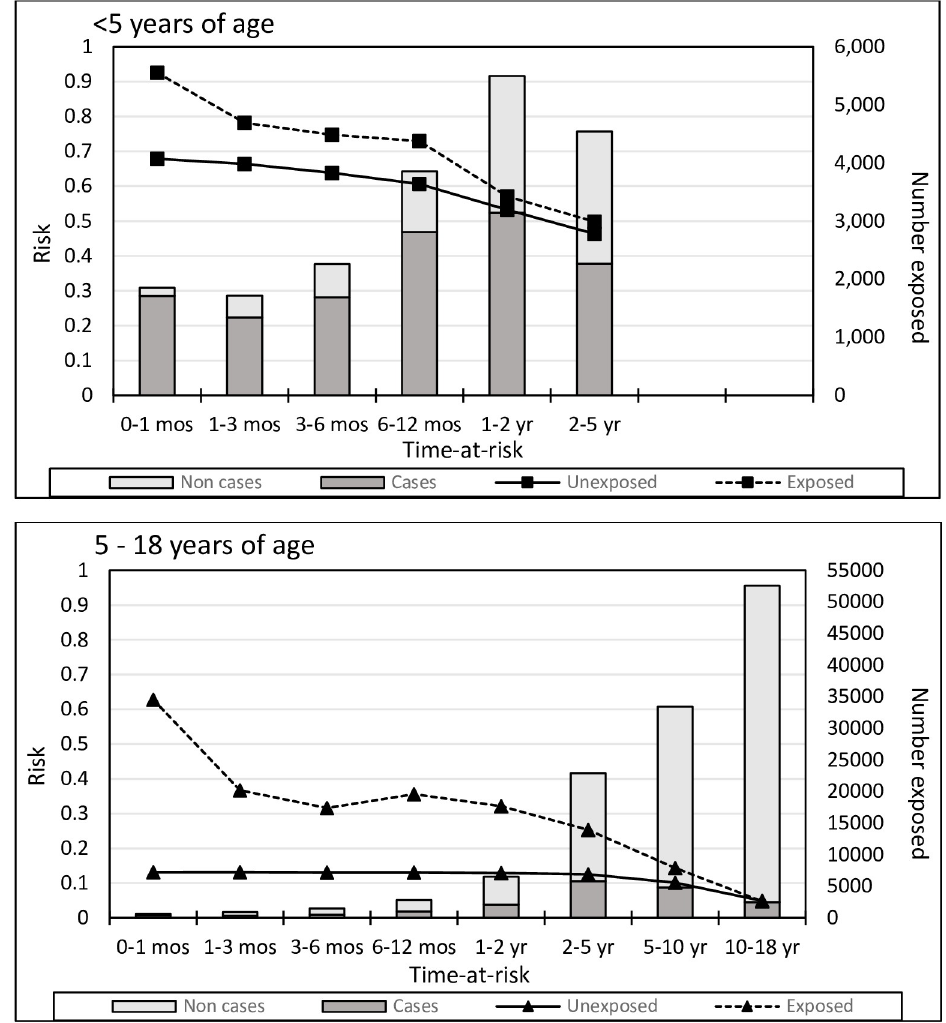
Fig 4. Risk of 1 st occurrence infection-related hospitalization in children < 5 and 5–18 years old, by time-at-risk. In the exposed group, ‘time-at-risk’ is the time from the first sibling infection-related hospitalization (occurring prior to the 1 st proband infection-related hospitalization) to the 1 st proband infection-related hospitalization or end of study, whichever occurred first. In the unexposed group, ‘time-at-risk’ begins with the start of follow-up. Follow-up times shorter than the ‘time-at-risk’ interval were not included in the interval risk calculations. ‘Cases’ refers to probands with infection-related hospitalizations; ‘Non cases’ refers to probands with no infection-related hospitalizations.